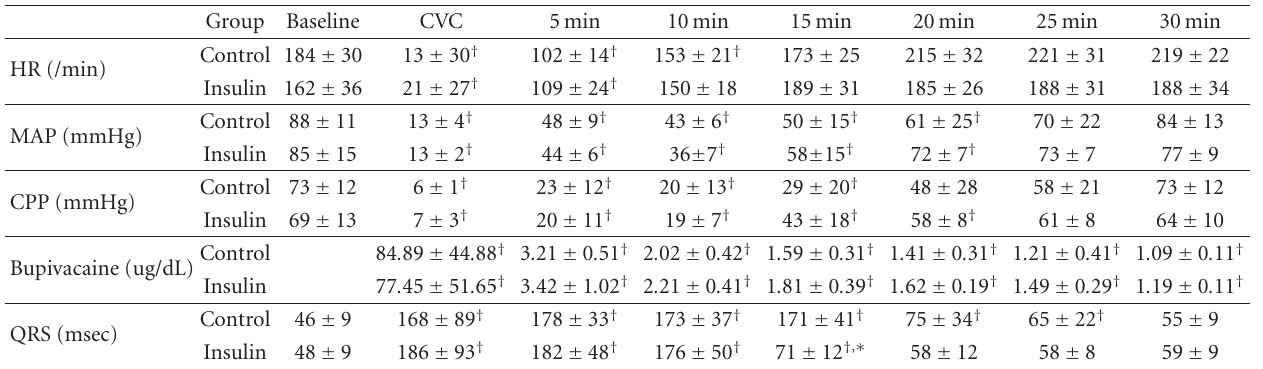
Table 1: Changes of hemodynamics, bupivacaine concentration and QRS duration in the control and insulin groups. Group Baseline